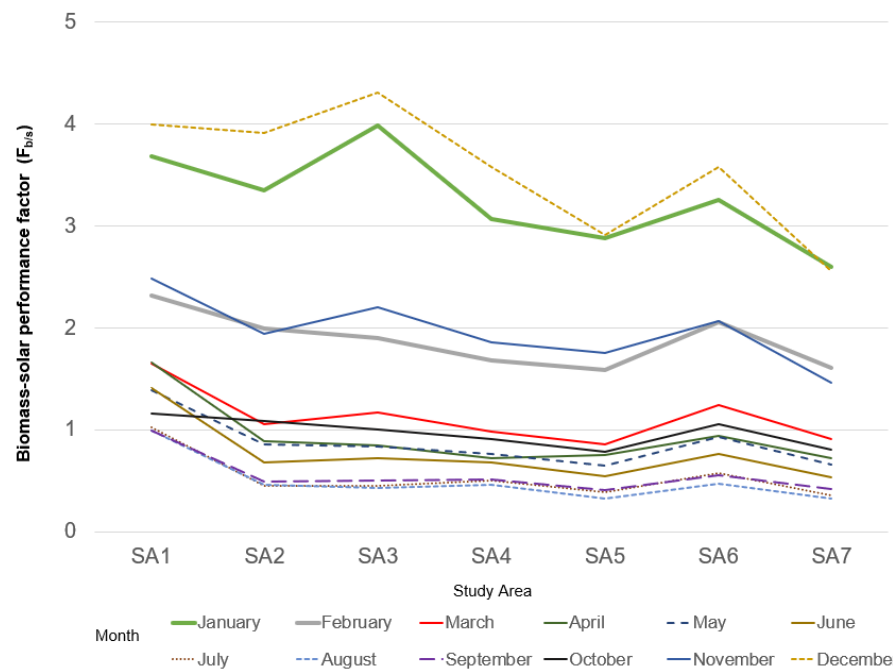
Figure 9. F-factors performance in the hybrid-modular system per month by sector.